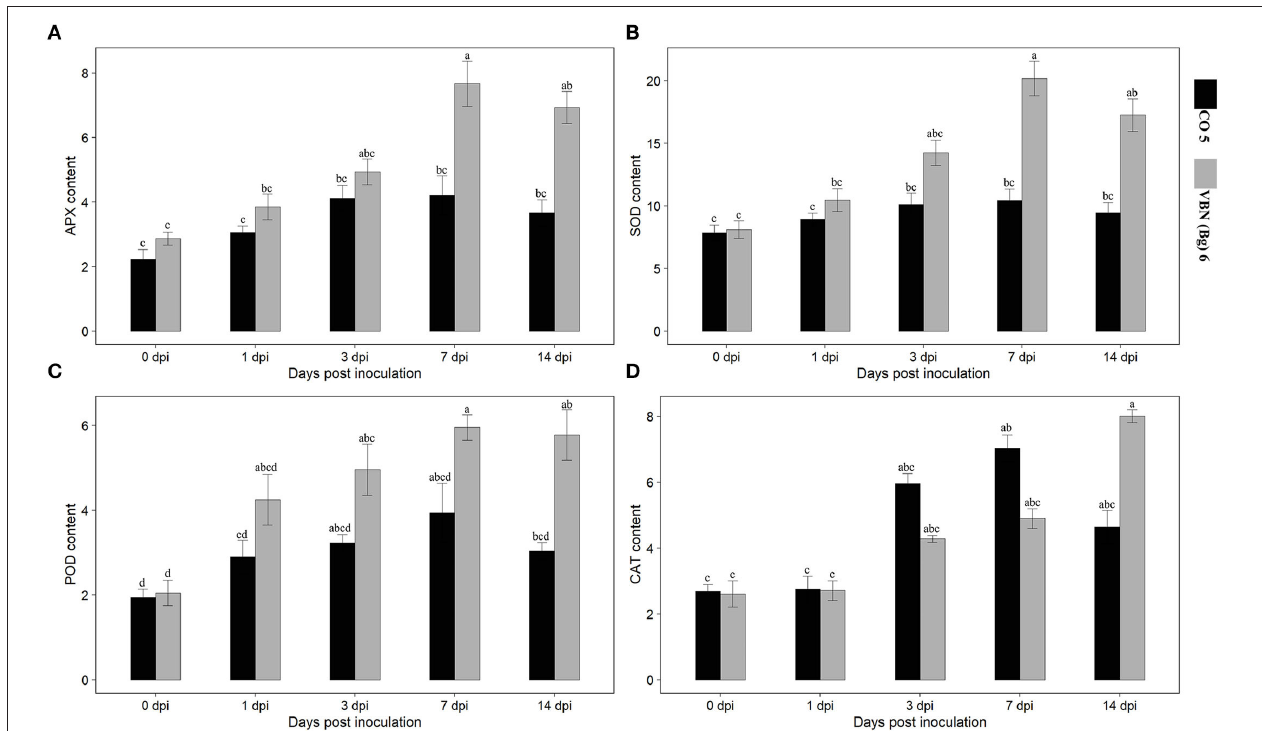
FIGURE 2 | Activities of antioxidants in two blackgram cultivars VBN (Bg) 6 and CO 5 after urdbean leaf crinkle virus infection. (A) APX (Umg − 1 Protein), (B) SOD (Umg − 1 Protein), (C) POD (Umg − 1 Protein), and (D) CAT (Umg − 1 Protein). Values followed by the same letter are not significantly different ( p ≤ 0.05) according to Duncan’s multiple range test. Bars present mean ± SE ( n =